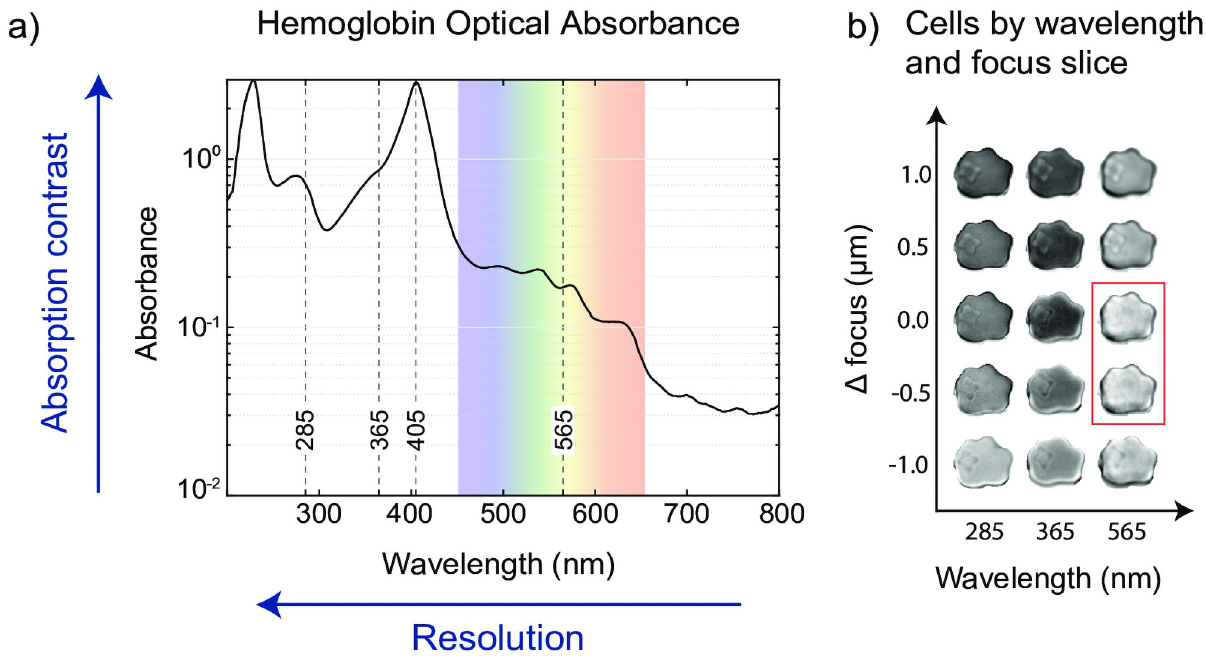
Fig 4. Wavelength and focus affect parasite contrast and classification efficiency. a) Optical absorption spectrum of hemoglobin is plotted, with the visible portion of the spectrum highlighted in color. Vertical dashed lines indicate the wavelengths used for imaging on the UV scope (285, 365, and 565 nm), and on the commercial microscope (365, 405, and conventional visible spectrum LED). The hemoglobin (Hb) spectrum is suggestive that parasite identification should be influenced by absorption contrast (highest at peaks), while the shortest wavelengths enable the highest resolution (highest at short wavelengths). b) An array of images of the same ring-stage infected RBC generated by multi-dimensional image registration, enabling assessment of classifier performance as a function of wavelength and focal offset. The parasite becomes nearly impossible to observe in some of the focus slices at 565 nm (red box), illustrating the benefit of increased contrast and